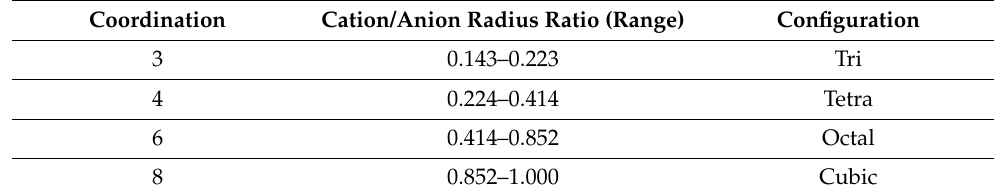
Table 3. Configuration of ionic radius.